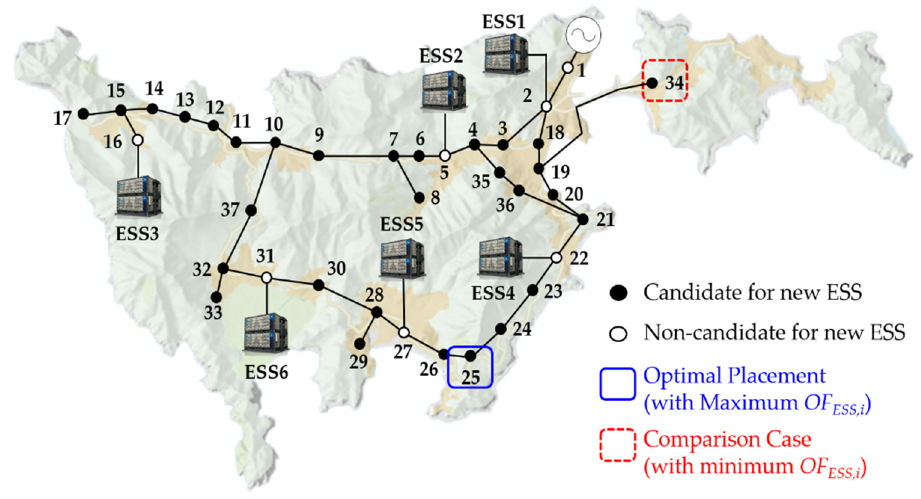
Figure 2. One-line diagram of the stand-alone microgrid in South Korea. Table 3. Priority analysis according to the installation placement of a newly installed ESS. Table 2. Load demands of the stand-alone microgrid. Bus No. SP ESS , i